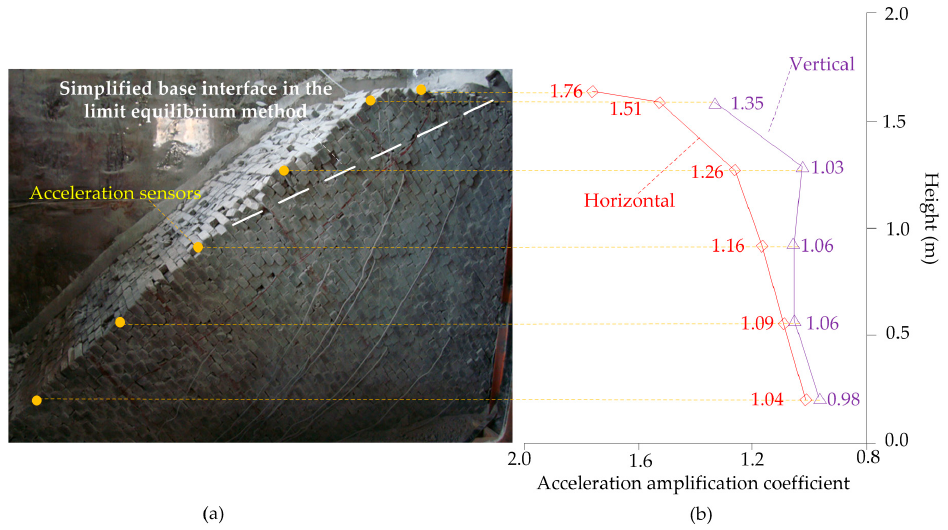
Figure 6. The large scale shake table test on anti-dip layered slope model: ( a ) the layout of acceleration sensors on the surface and the failure status of the slope model (modified based on [26]); ( b ) the acceleration amplification coefficients increase with slope height on the slope surface (data from [26]).